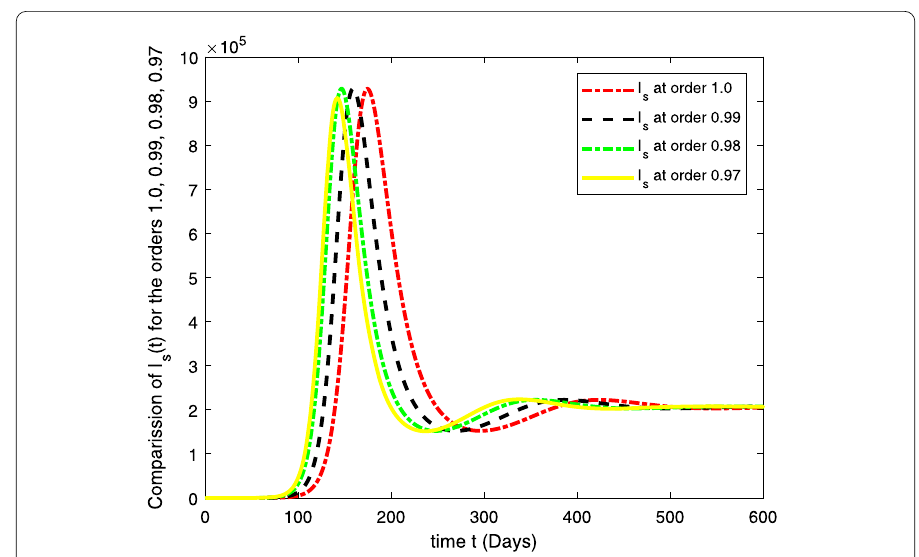
Figure 7 Computational results for I s ( t ) for the fractional orders 1.0, 0.99, 0.98, 0.97